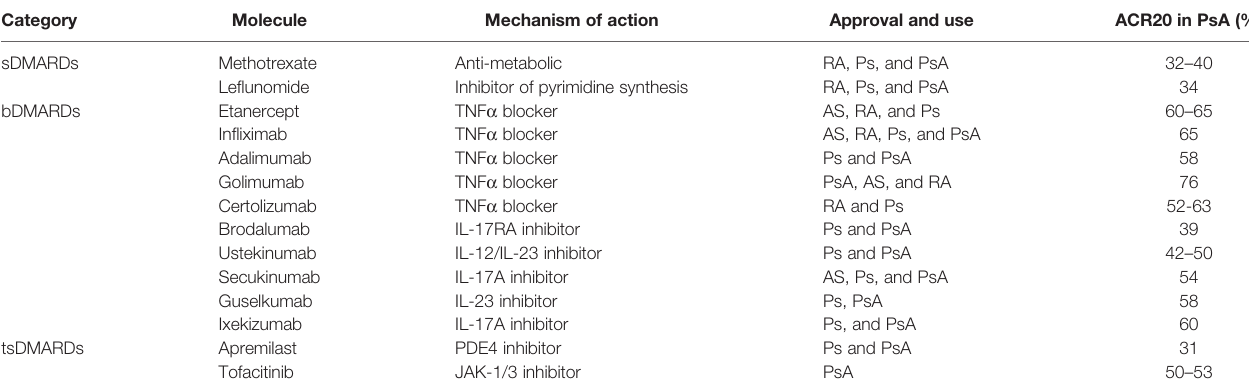
TABLE 2 | Overview of the current treatments in PsA and related mechanism of